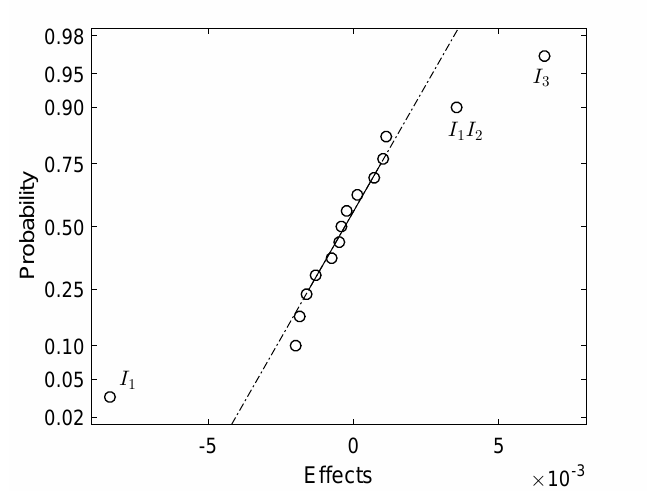
Figure 13. Normal probability plots for stage III showing effects on efficiency (total to total).